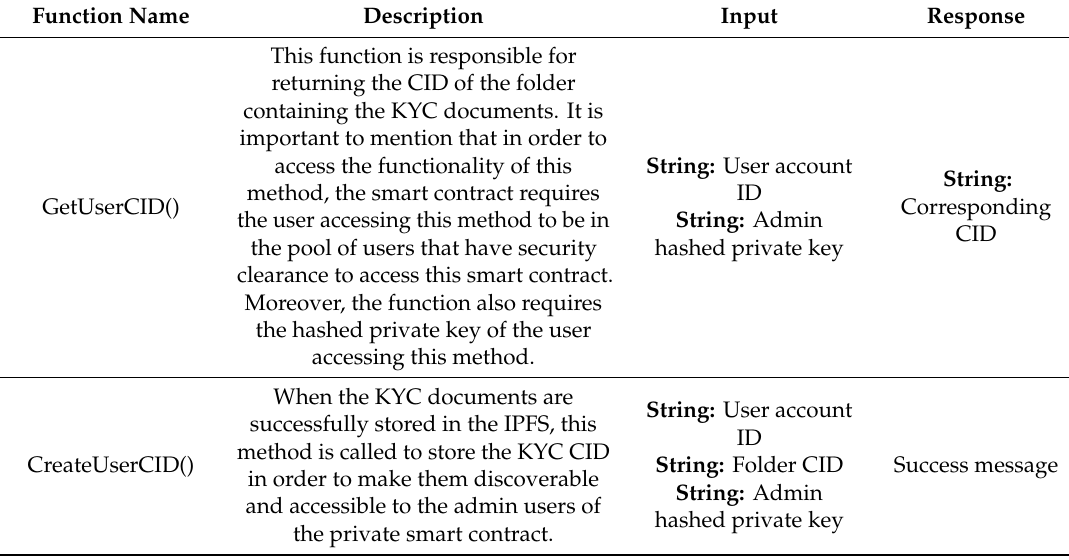
Table 2. Private smart contract methods